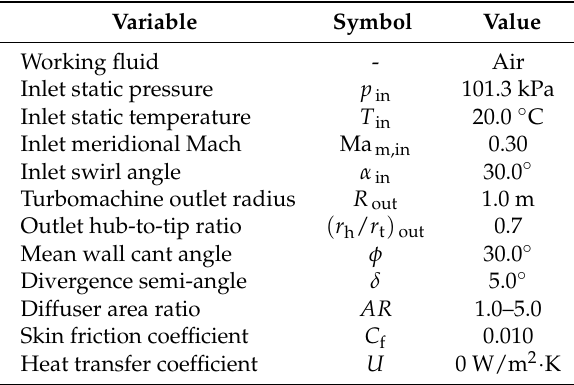
Figure 7. Comparison of model output with the data from Kumar and Kumar [30]. Table 3. Definition of the reference